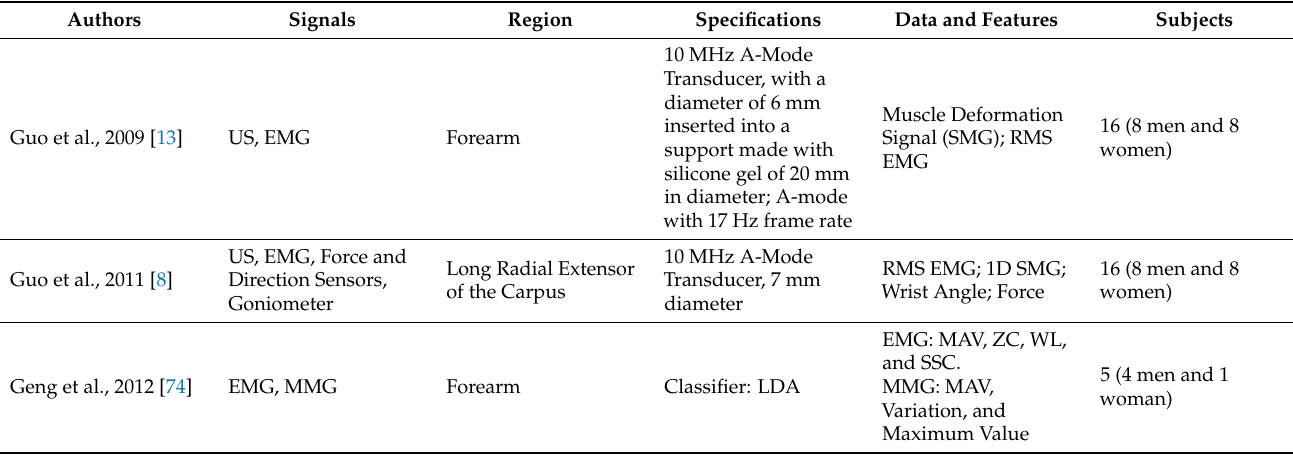
Table 1. Summary of HMI